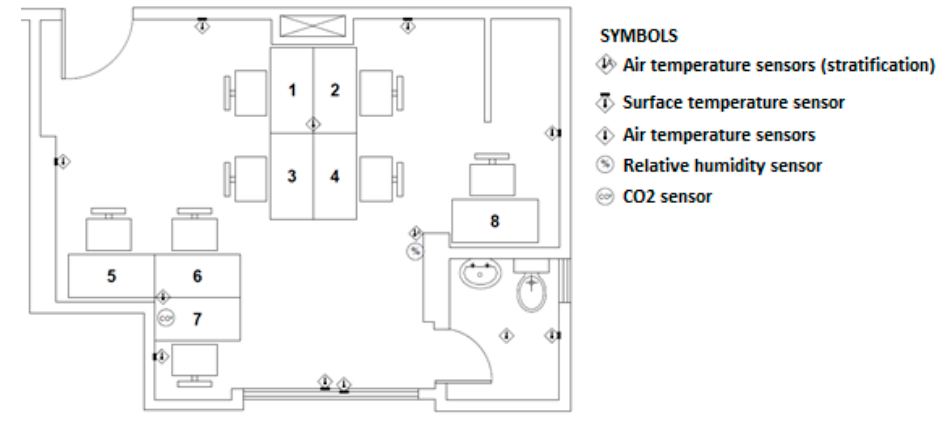
Table 2. Monitoring parameters and specification of monitoring equipment.